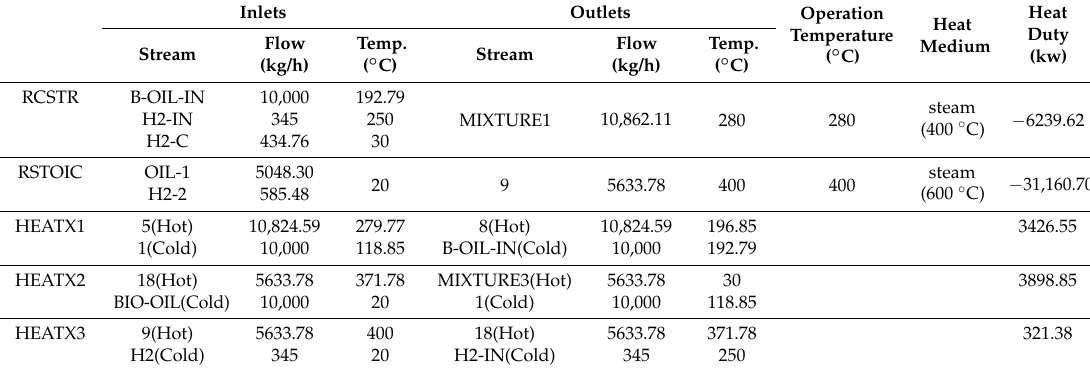
Table A5. Energy analysis of the overall process at 280 ◦ C and 8 MPa and deep hydrogenation at 400 ◦ C and 15